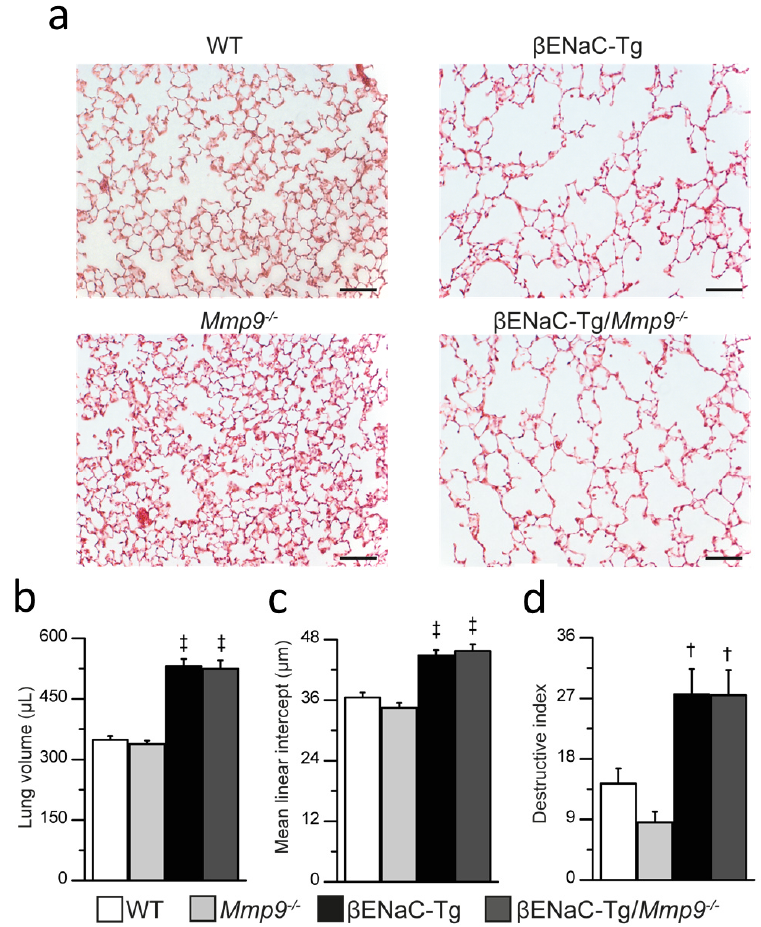
Figure 5. Genetic deletion of Mmp9 does not reduce emphysema-like structural lung damage in β ENaC-Tg mice. ( a ) Representative morphology of distal airspaces in hematoxylin and eosin–stained lung sections of 6–8-week-old WT, Mmp9 -/- , β ENaC-Tg and β ENaC-Tg/ Mmp9 -/- mice. Scale bar, 100 µ m. ( b – d ) Structural lung damage was assessed by measurements of lung volume ( b ), mean linear intercepts (MLI) ( c ), and destructive index ( d ). † p < 0.01 compared to WT or Mmp9 -/- , ‡ p < 0.001 compared to WT or Mmp9 -/- , n = 9–32 mice per group. Statistical analysis was performed with one ‐ way ANOVA.